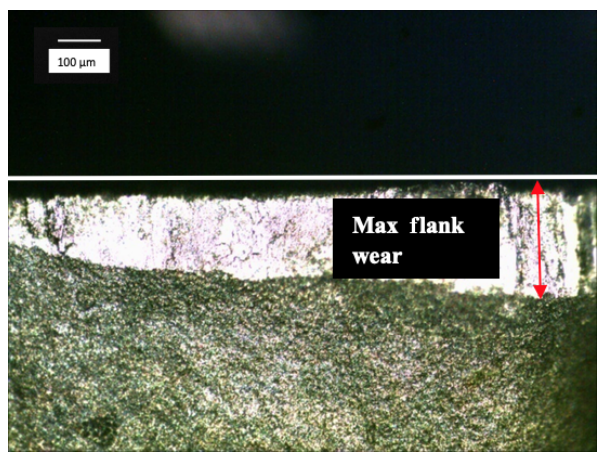
Figure 3. Optical microscopy image showing maximum flank wear.